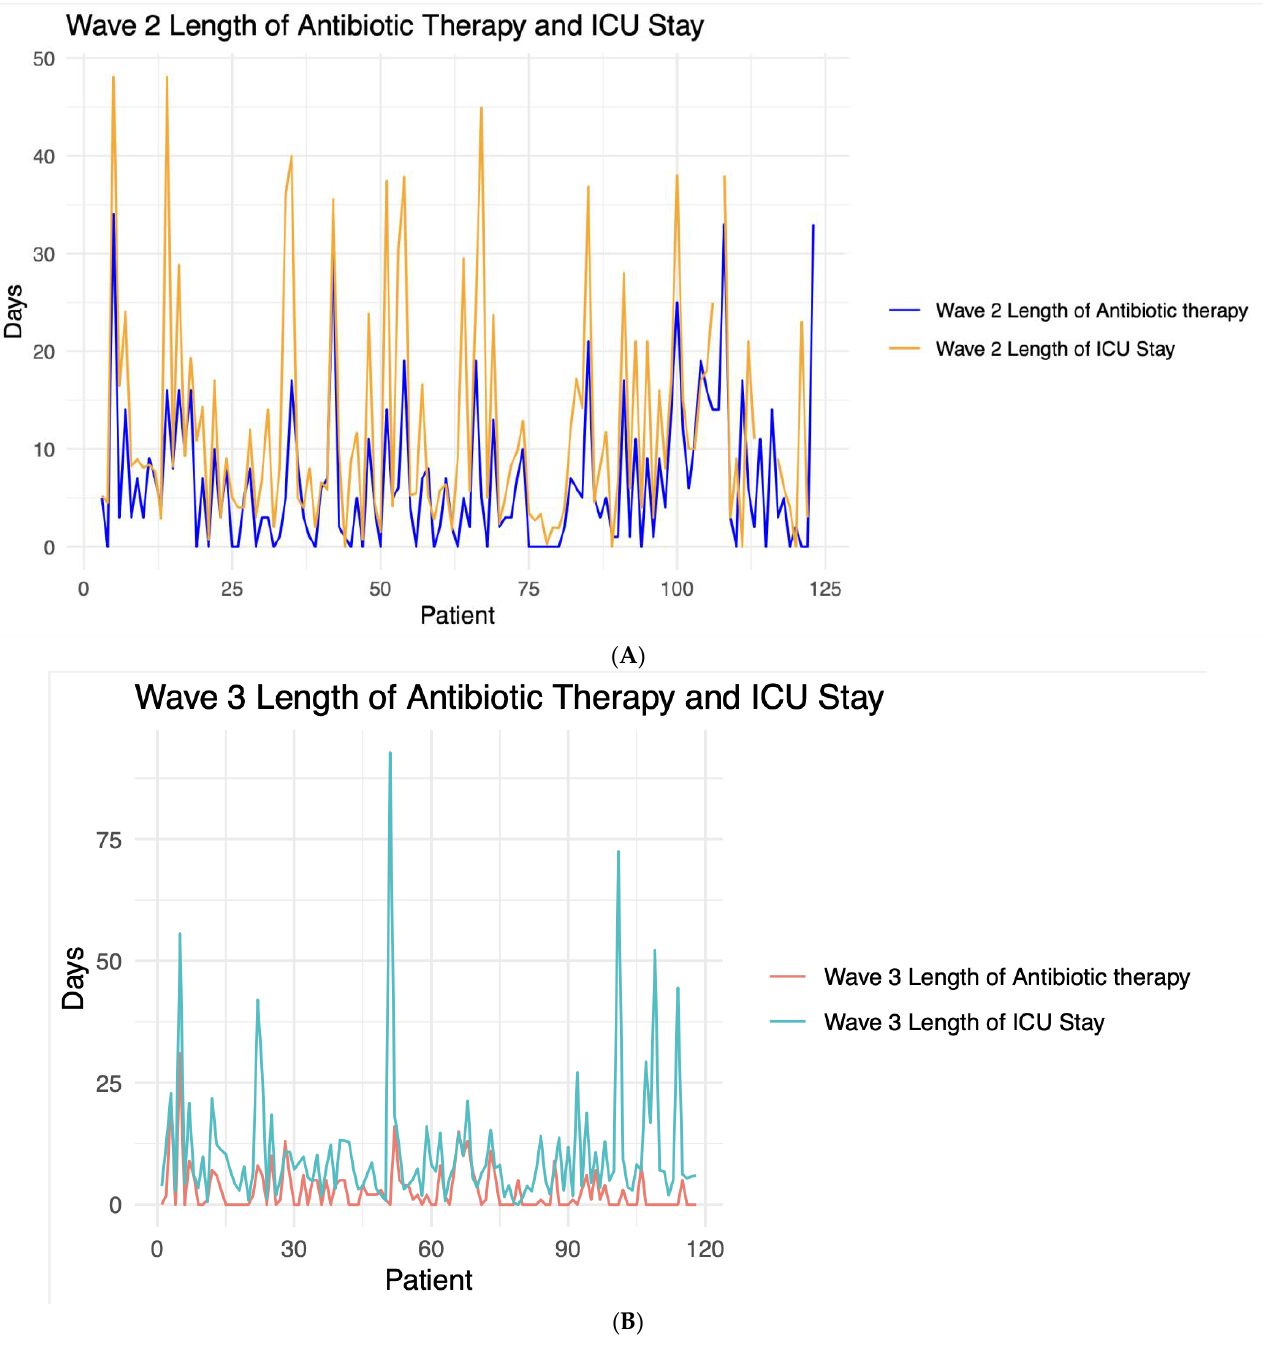
Figure 7. Line graph contrasting the length of antibiotic / antimicrobial therapy and length of Intensive Care Unit (ICU) stay for each patient during ( A ) Wave 2 and ( B ) Wave 3.